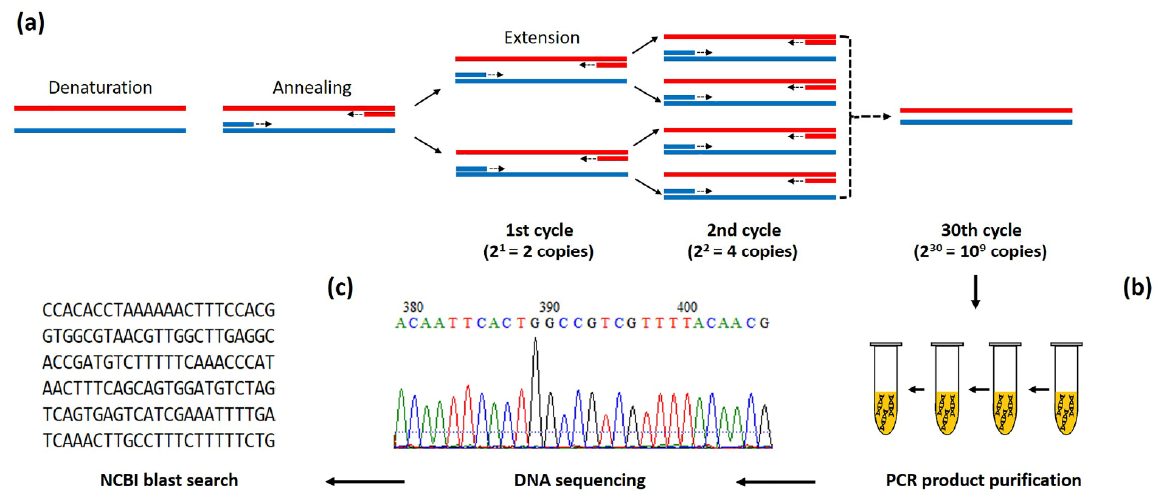
Figure 4. Scheme of the PCR amplification and sequence homology analysis for detecting P. insidiosum